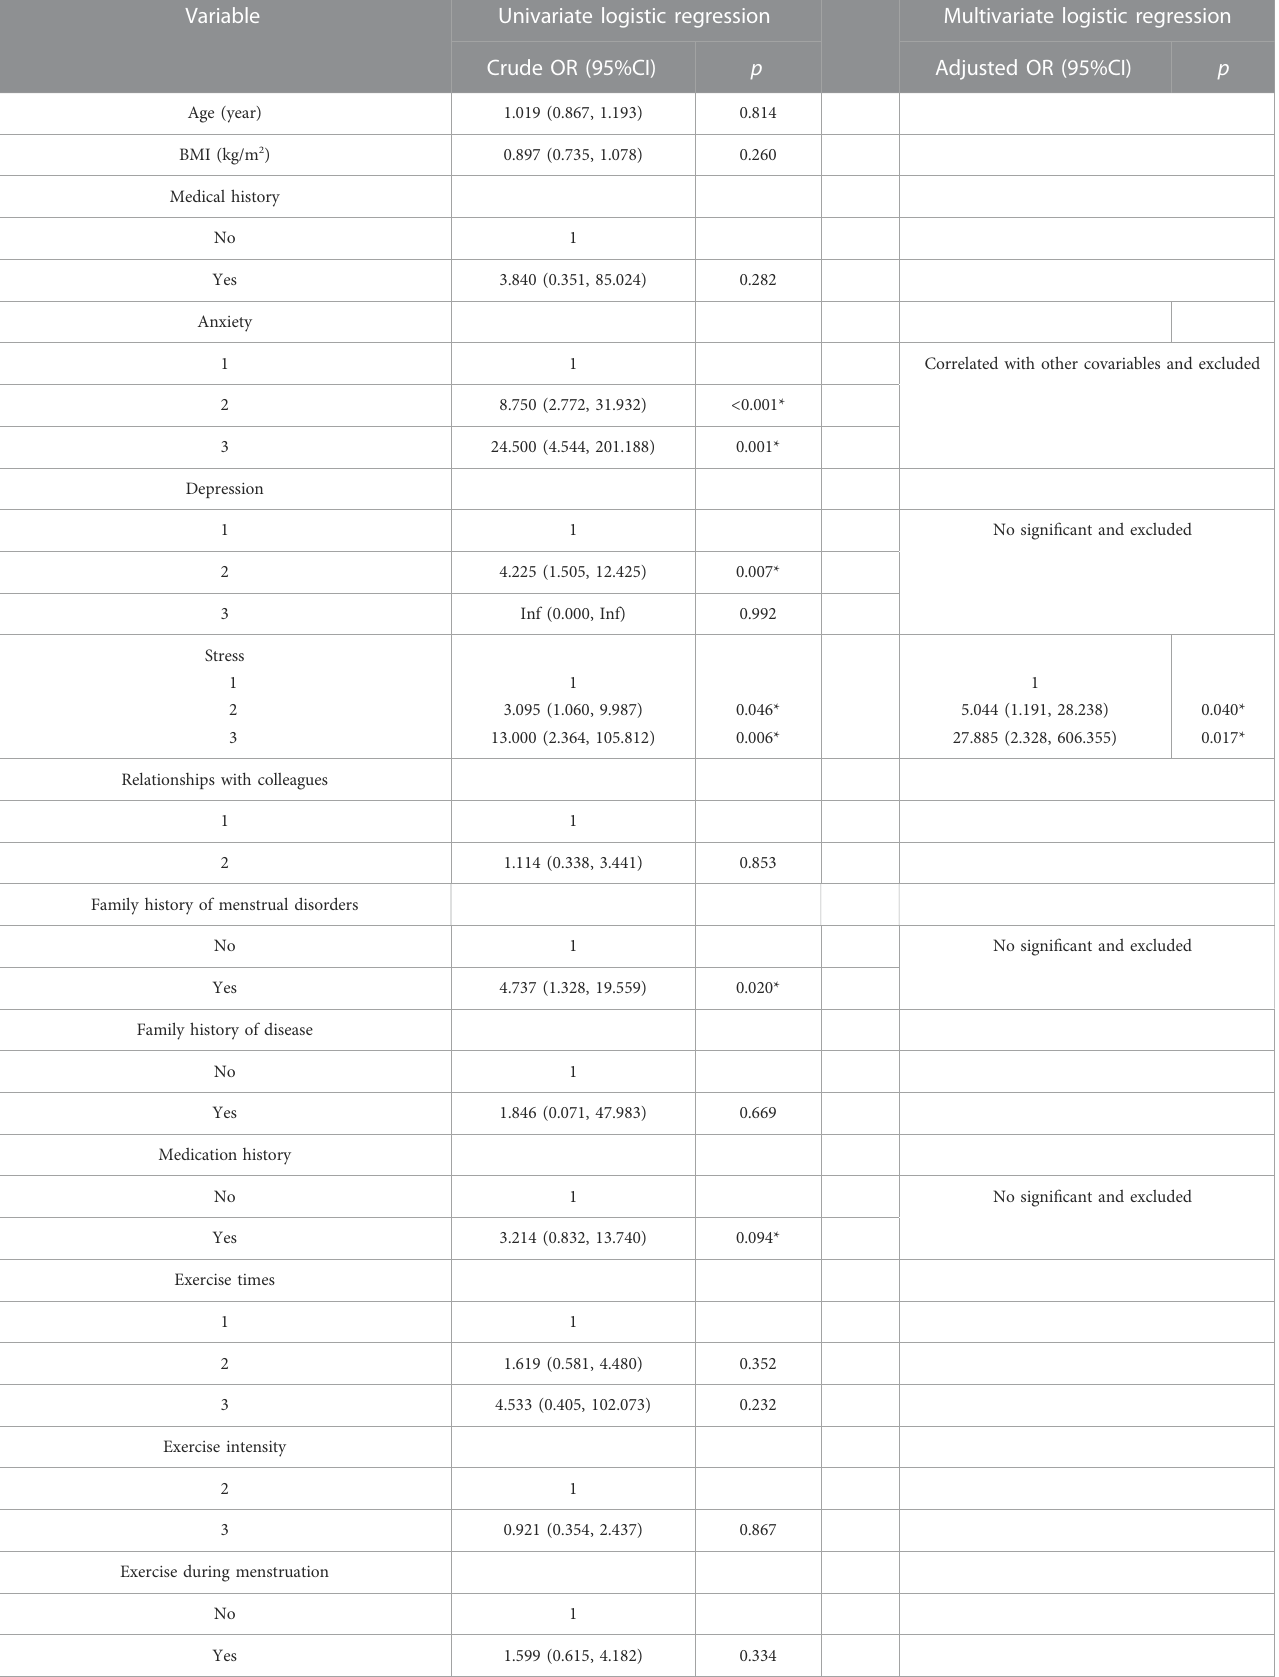
TABLE 3 Logistic regression analysis to menstrual disorders and variable in two